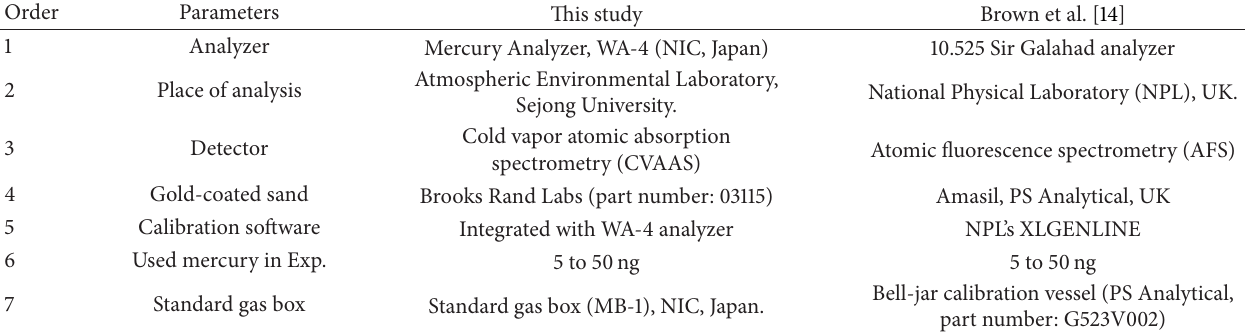
Table 2: The experimental settings used in this study and a previous study (Brown et al., 2011